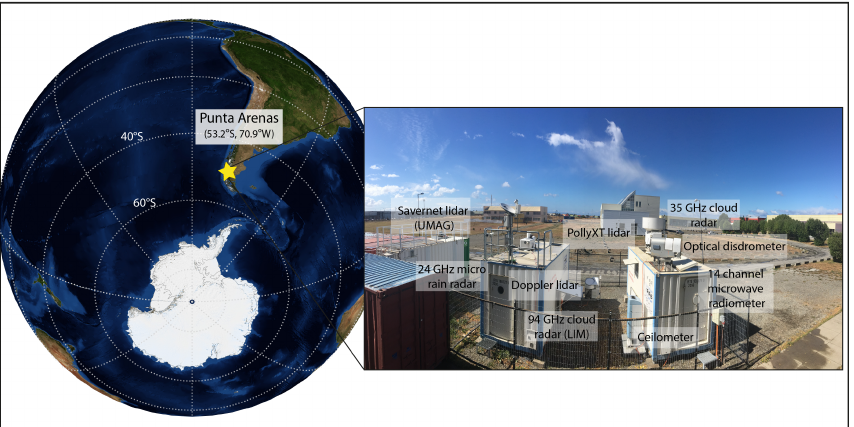
Figure 1. Map of the location of Punta Arenas (indicated by a yellow star) in Chile, South America. The LACROS observational facility, as deployed at UMAG, can be seen on the right